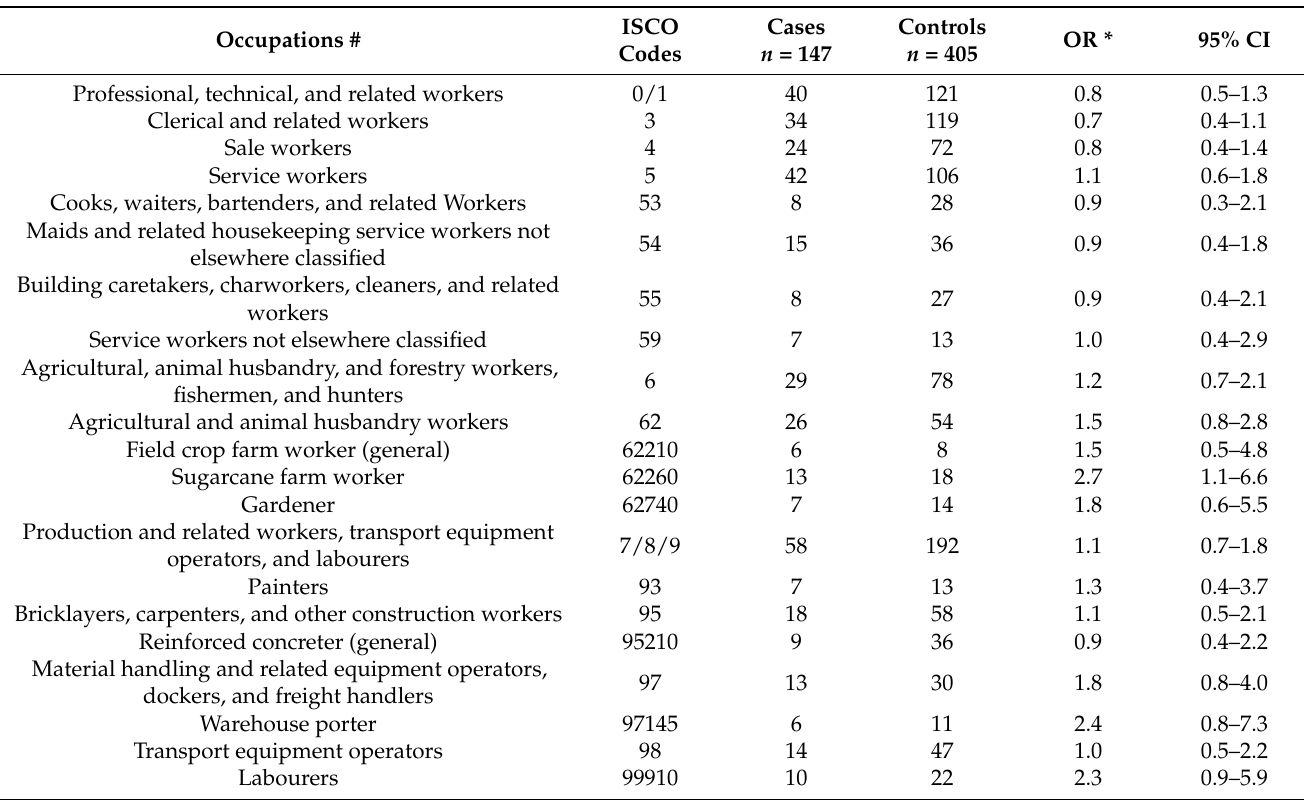
Table 1. Association between selected occupations and lung cancer risk in the French West Indies